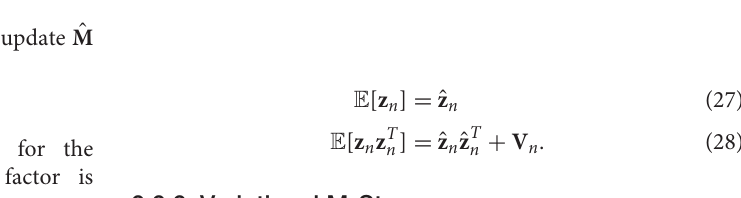
ˆ M and ˆ W ), and a variational M-step that uses q ( Z ) to update ˆ M and ˆ W . These two steps are outlined